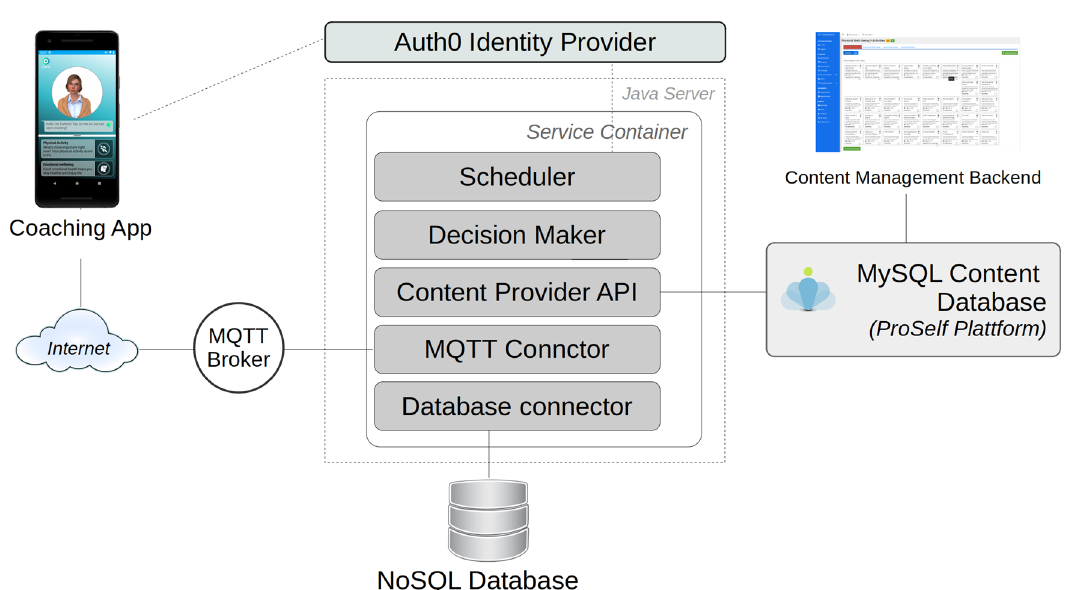
Figure 2. Overall components of the system.